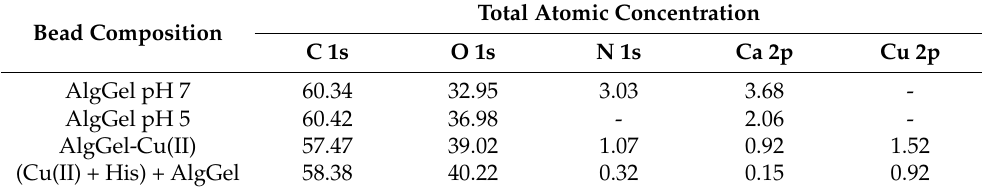
Table 1. Element chemical composition of the alginate adsorbents before and after copper ion adsorption or histidine addition based on XPS. The pristine alginate pH values correspond to the alginate beads’ storage